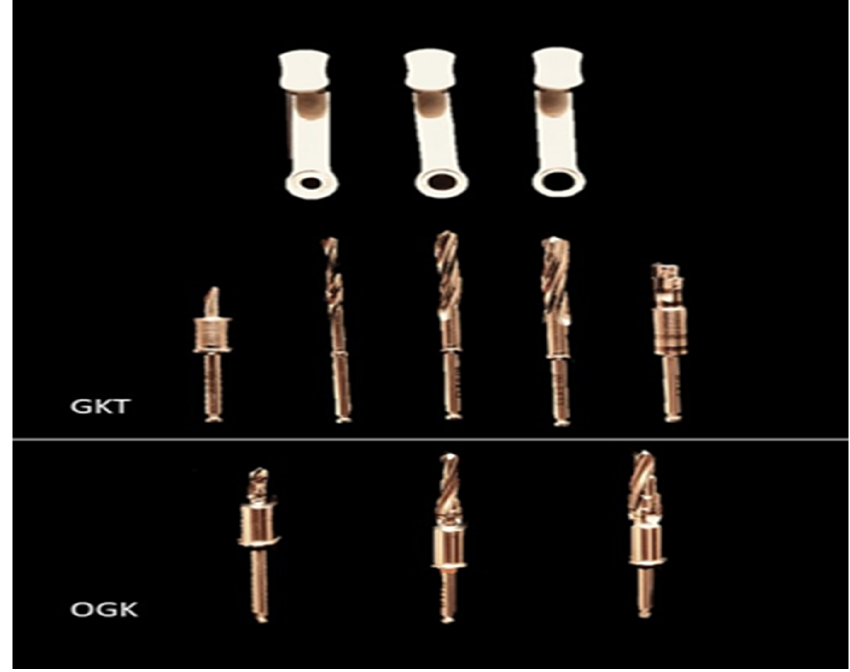
Figure 8. Comparison of number of tools required to prepare 4.0 × 10 mm implant site with GKT ( upper ) and OGK ( lower ).